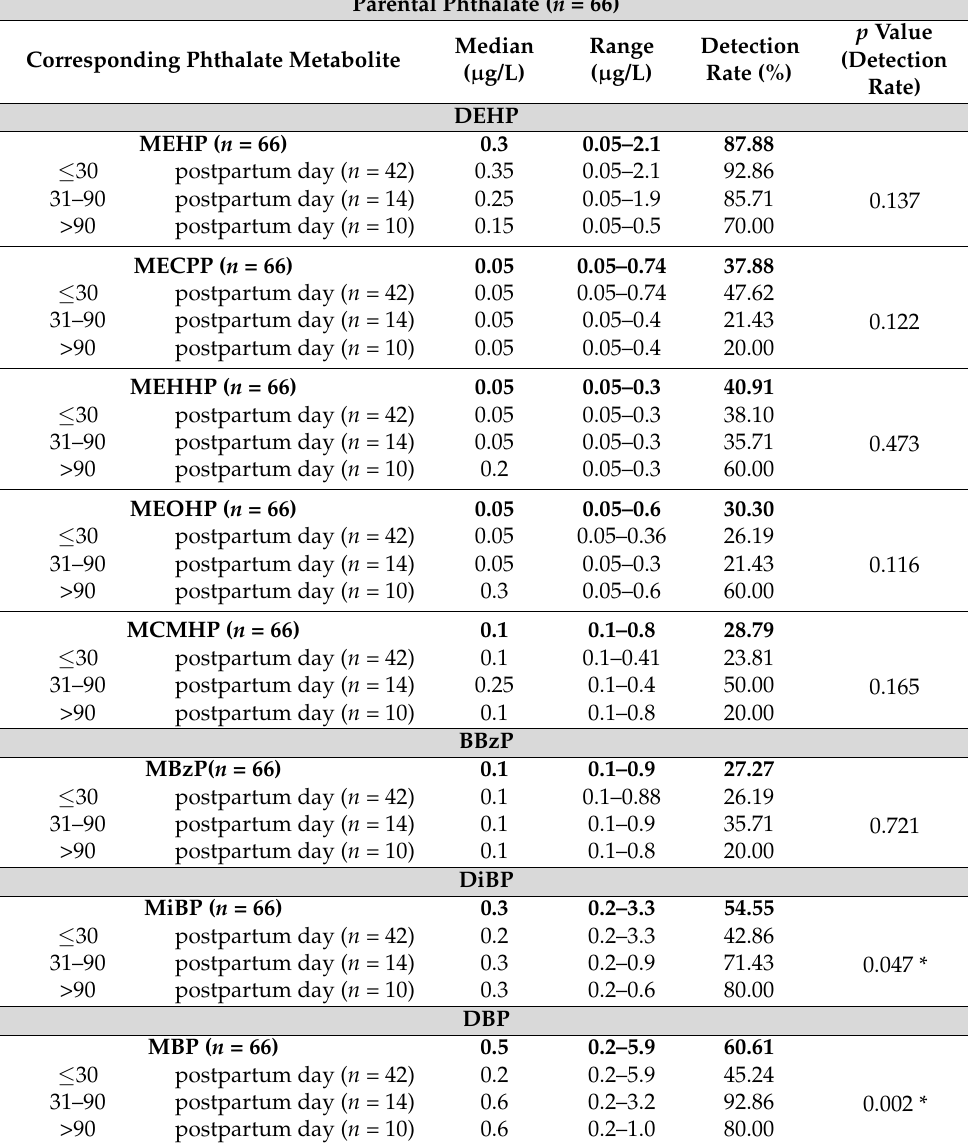
Table 2. Phthalate metabolites levels and detection rates in breast milk